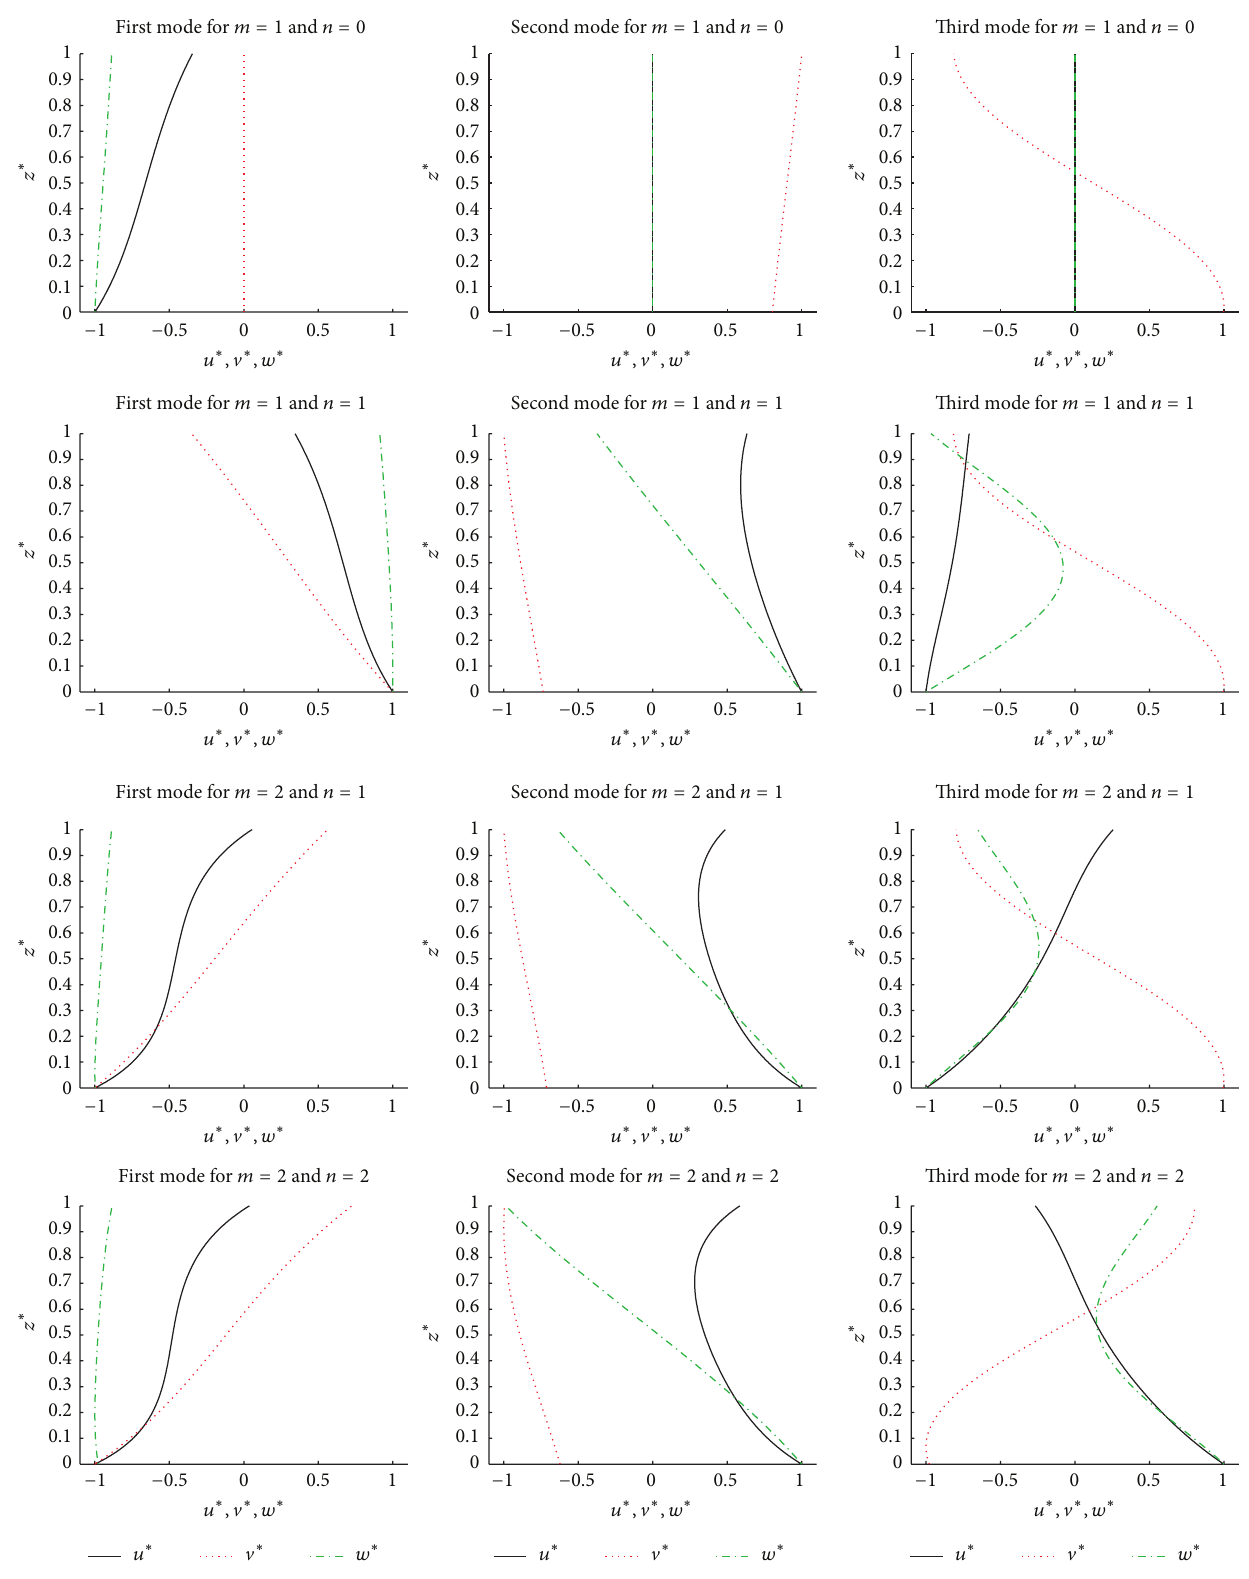
Figure 11: Benchmark 10, simply supported orthotropic spherical shell panel (𝜃 = 0 ∘ ). First three vibration modes in terms of displacement components through the thickness for thickness ratio 𝑅 𝛼 /ℎ = 5 and several combinations of half-wave